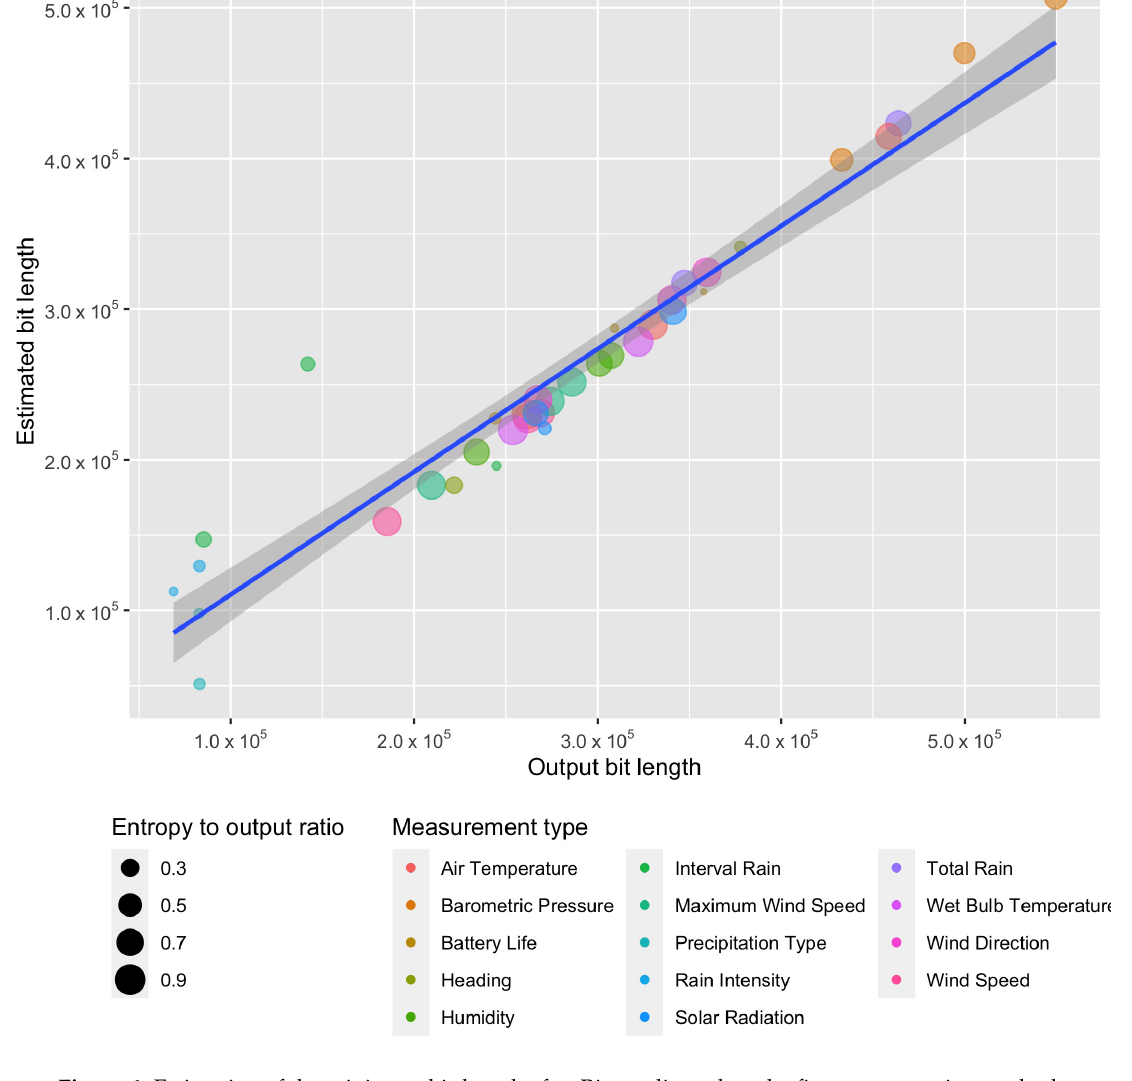
Figure 4. Estimation of the minimum bit-length after Rice coding when the first preprocessing method is